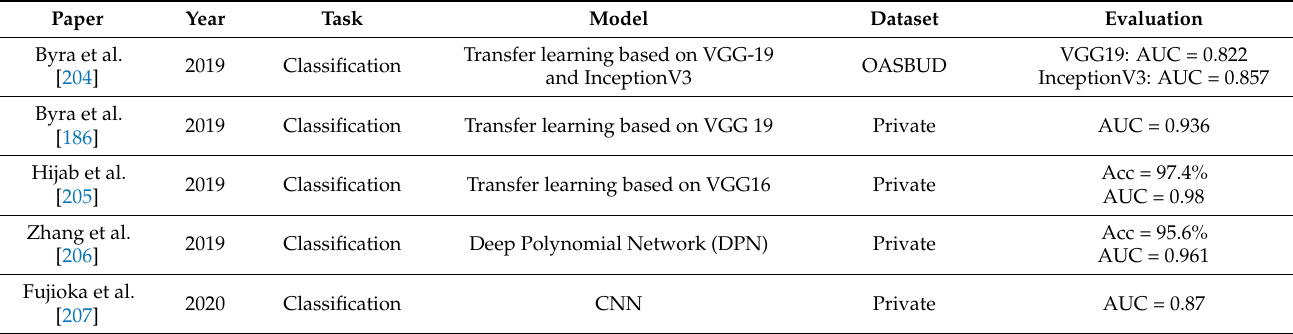
Table 4. The summary of the studies that used ultrasound